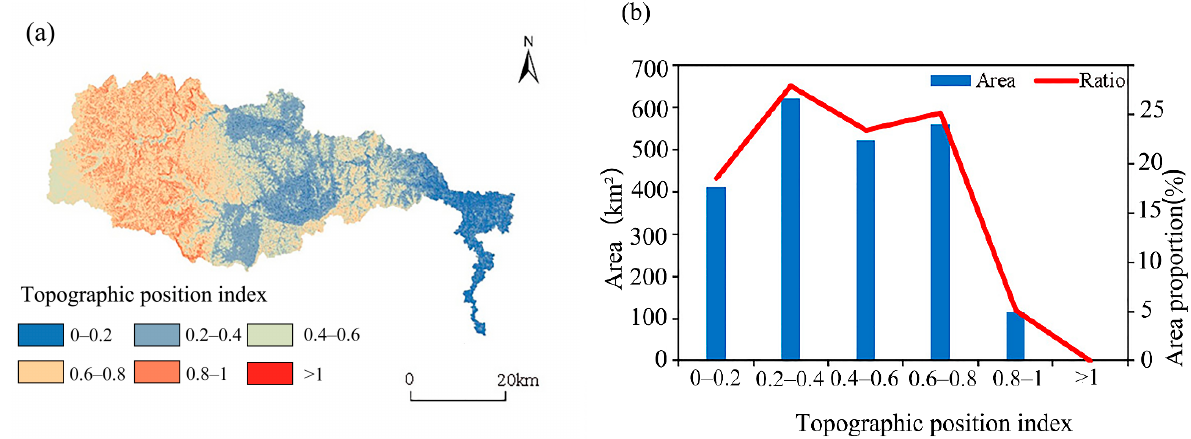
Figure 5. Topographic position index distribution map ( a ) and land-use type area by different topographic position index ( b ).